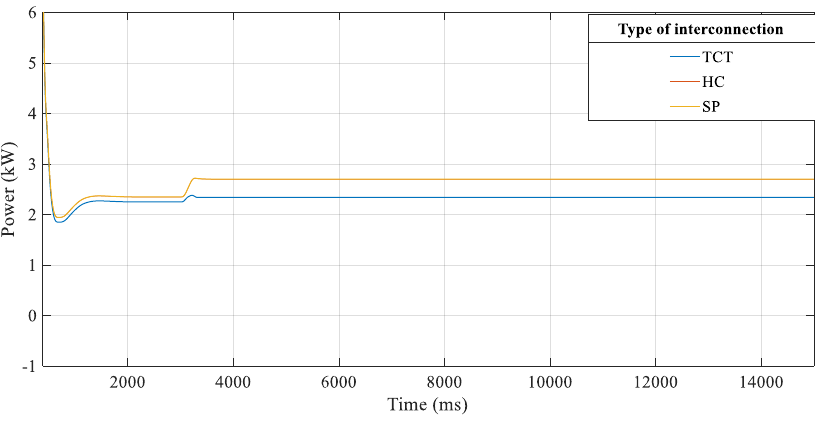
Energies 2019 Figure 20. Impact of open- circuit fault ‘F1′ on power grid (thin-film PV). Figure 20. Impact of open-circuit fault ‘F1 (cid:48) on power grid (thin-film PV).